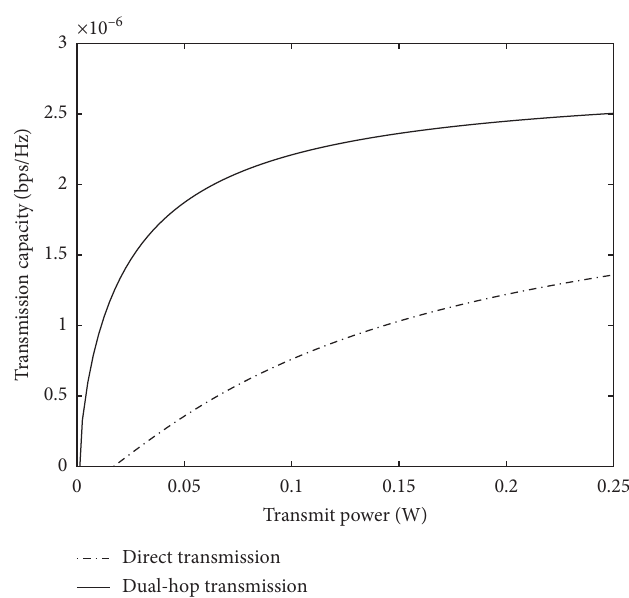
Figure 4: Comparison of single-hop and dual-hop transmission capacity.